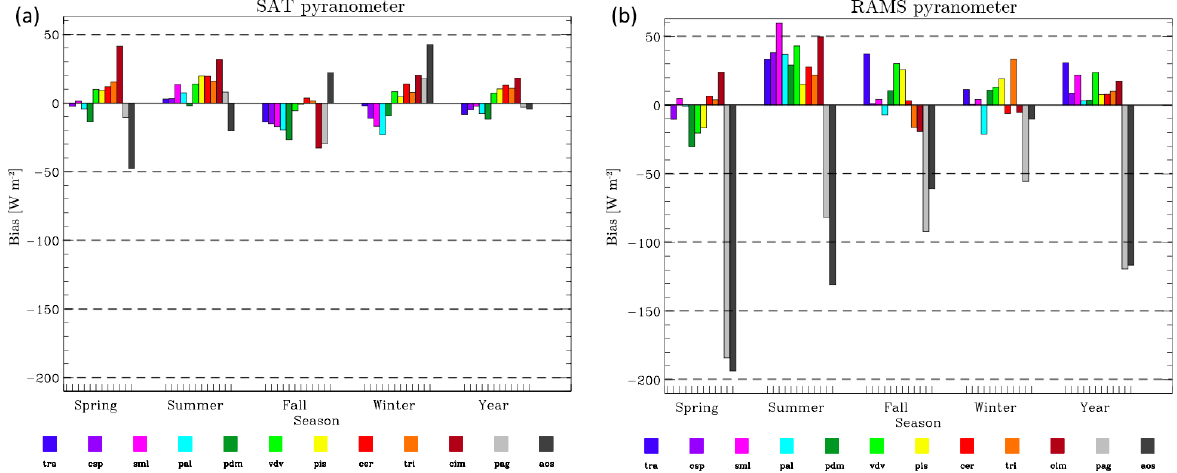
Figure 5. (a) MBE for the MSG-GHI for the different stations and seasons as well as for the whole year. The figure has been derived from the hourly data of pyranometers and MSG-GHI estimate; (b) as in (a) for the RAMS